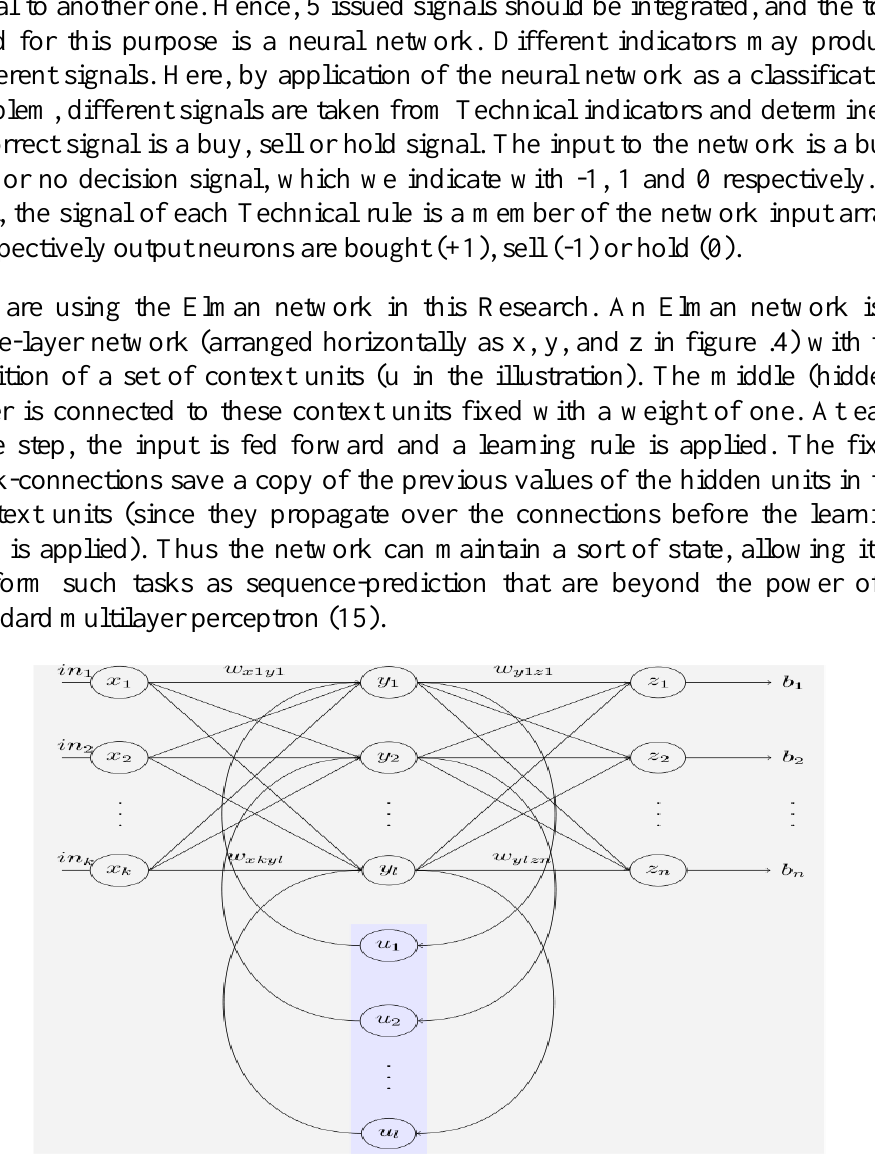
Figure 4. A View from Elman